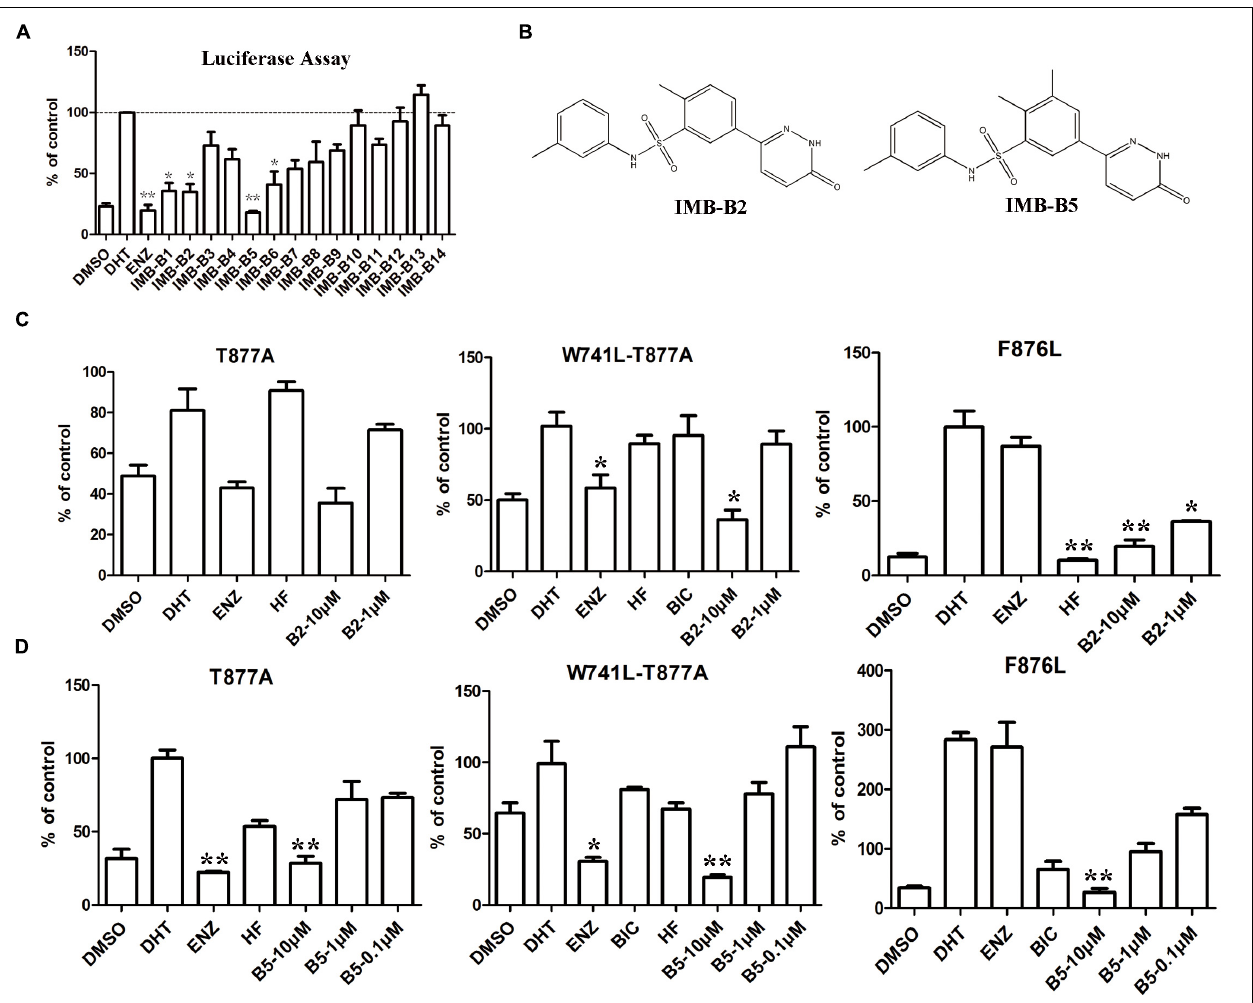
FIGURE 6 | Identify IMB-A6 analogs as antiandrogens. (A) The dual-luciferase assay of AR activity in LNCaP cells for the analogs of IMB-A6. (B) The chemical structures of IMB-B2 and IMB-B5. (C) IMB-B2 demonstrated effective antiandrogenic activity in suppressing DHT-induced transcriptions of the F876L, T877A, and W741C+T877A AR mutants. (D) IMB-B5 demonstrated effective antiandrogenic activity in suppressing DHT-induced transcriptions of the F876L, T877A, and W741C+T877A AR mutants. Experiments were in triplicate. ∗ P < 0.05, ∗∗ P < 0.01 vs. DHT group. BIC, bicalutamide; HF, hydroxyflutamide; ENZ, enzalutamide; DHT, dihydrotestosterone. All results are shown as mean ±